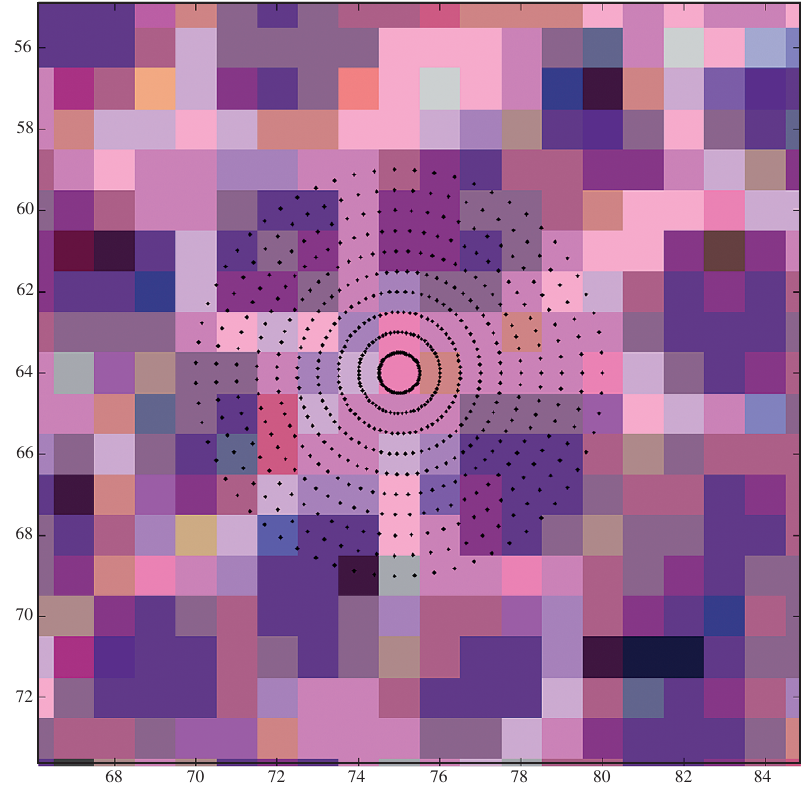
Fig. 1. Schematic demonstrating a SIVQ ring vector. For demonstration purposes, an representative example ring vector, sized 10 pixels in diameter and with 9 sub-rings, was superimposed on a pixel-level image. This image shows the relationship between the number of points on the ring that are sampled for analysis, as well as the orientation, sizes, and maximal number of subrings. For adequate sampling, Nyquist frequency theory dictates that sampling should occur at twice the maximum frequency, thus requiring sampling at every half pixel. For clarity, in this image the number of sampling points was determined by the size of the outer ring and held constant for the inner rings, though in general SIVQ recalculates the number of sampling points was calculated by Nyquist frequency theory at each ring